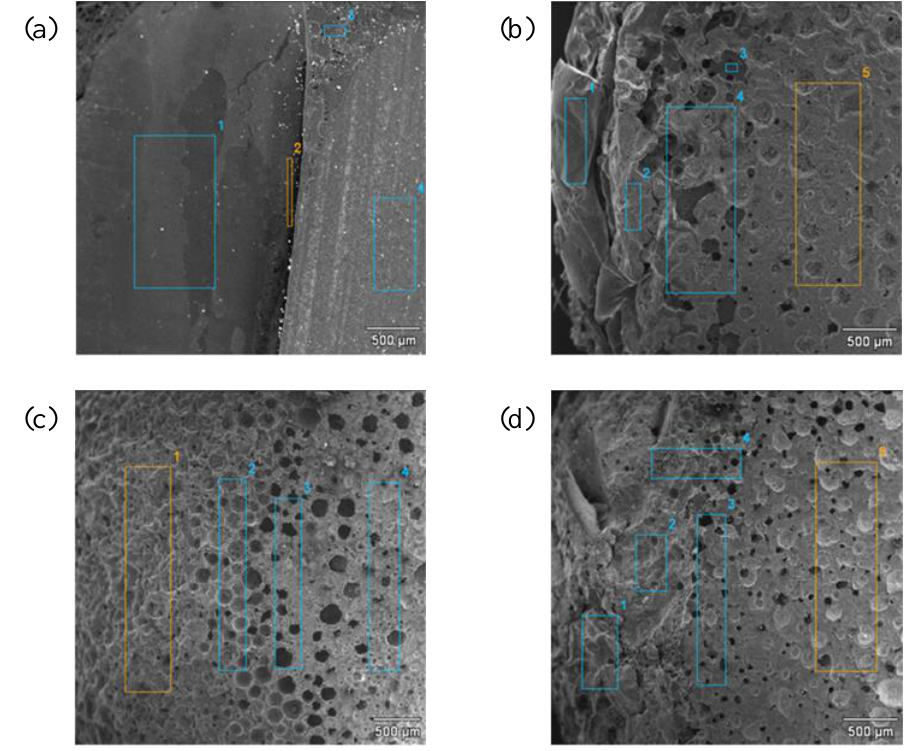
Figure 18. SEM microphotographs and EDS analysis results of samples of burnt EP ( a ) and composites; ( b ) EPBP1-3.0; ( c ) EPIHSP3-3.0; ( d ) EPBP1IHSP3-3.0.